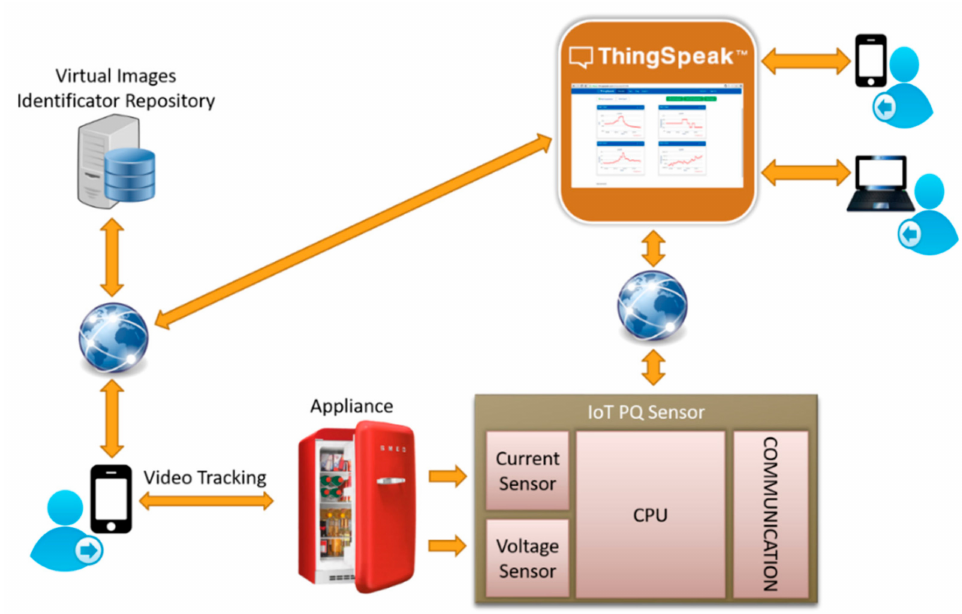
Figure 1. The overall architecture of the energy augmented reality (AR) application. IoT, Internet of Things; PQ, power